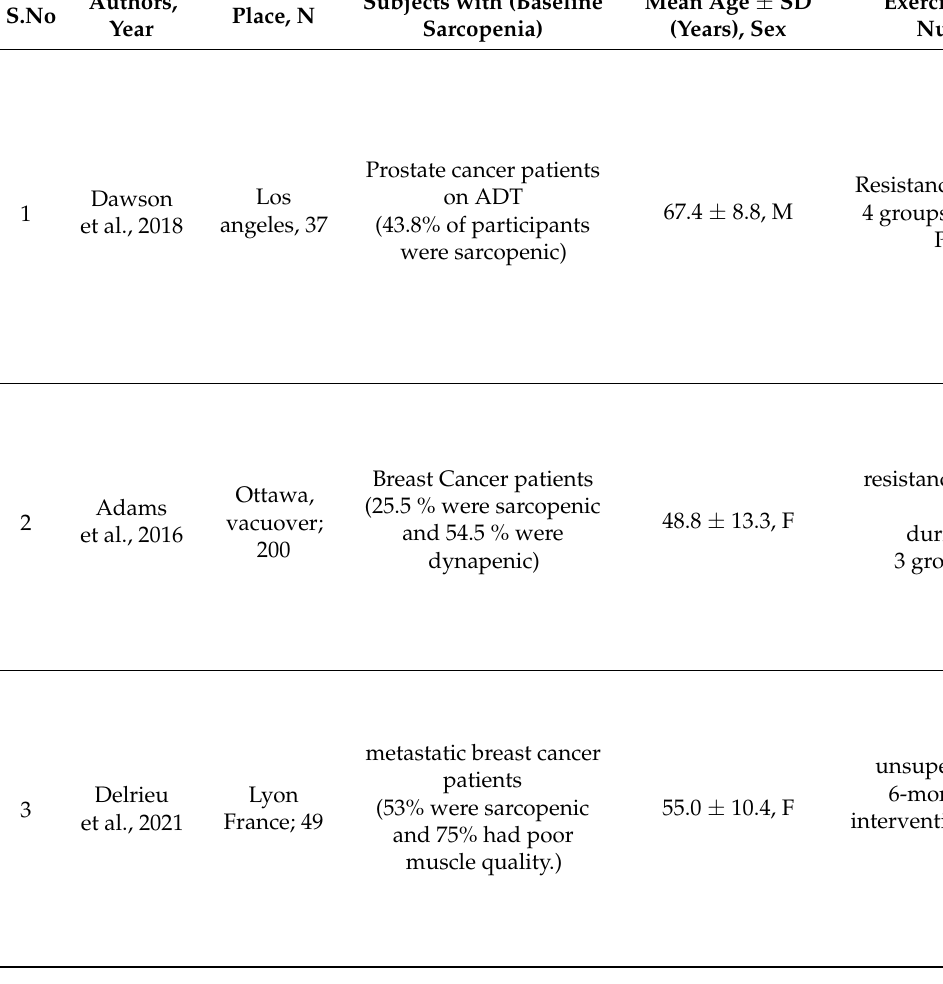
Table 1. Effect of exercise on subjects with cancer and baseline measurement of sarcopenia.